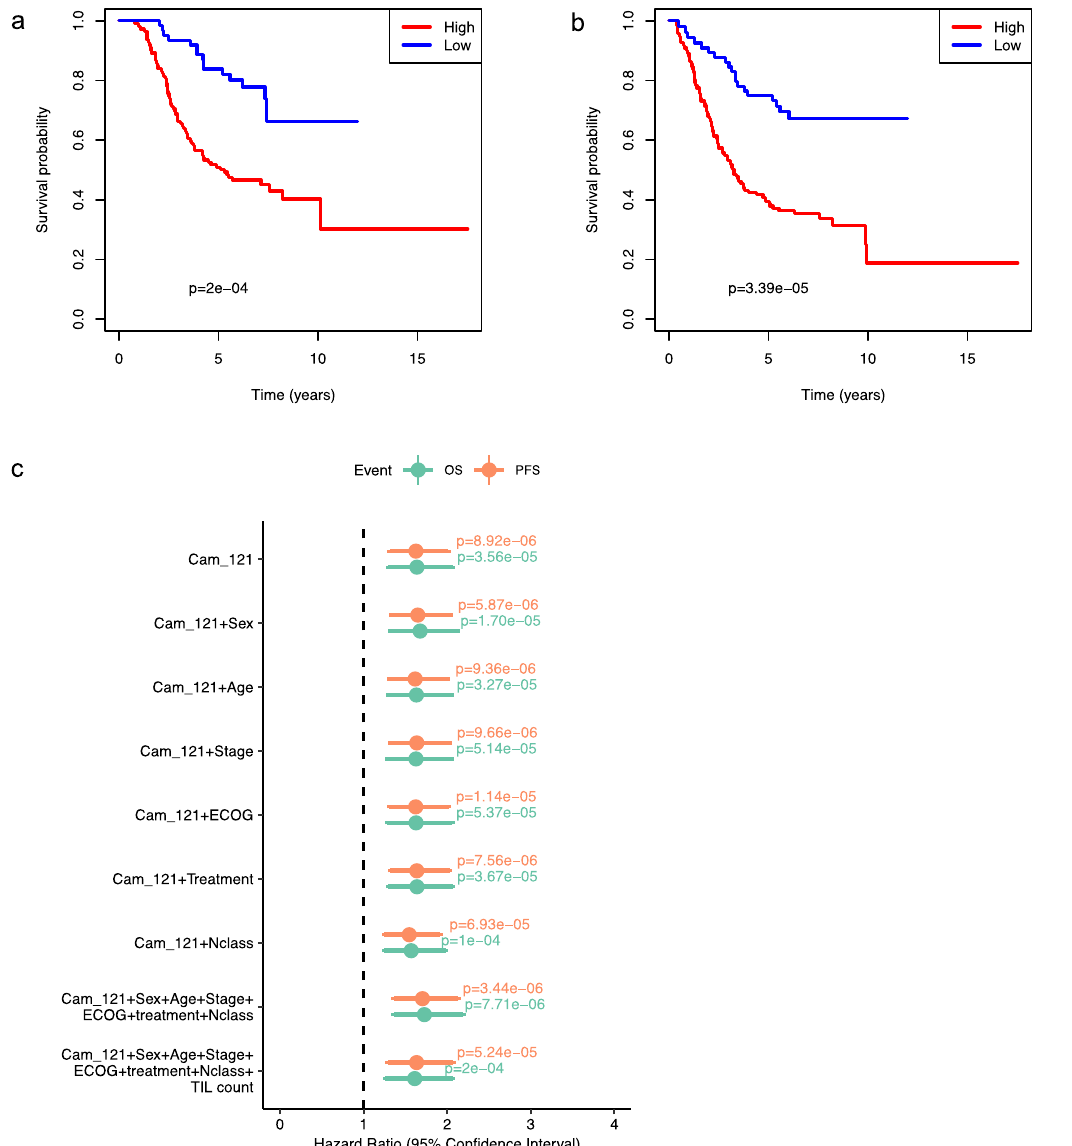
Cam_121 was associated with melanoma-speci fi c survival in both univariate (HR = 1.49 (95% CI 1.27 – 1.74), p = 5 × 10 − 7 ) and multivariate Cox regression models (HR = 1.7 (95% CI), p = 0.001, Fig. 2d, e). Owing to a lack of power when considering true primary melanomas within TCGA-SKCM dataset ( n = 87), samples from primary tumours were considered together with regional cutaneous relapsed tumours (de fi ned herein as “ Skin TCGA-SKCM ” ( n = 159)) and were tested separately from the regional LN samples ( n = 216). Cam_121 was associated with OS in both univariate (skin: HR = 1.50, 95% CI = (1.15, 1.96), p = 0.00273; LN: HR = 1.28, 95% CI = (1.06, 1.56), p = 0.0109) and